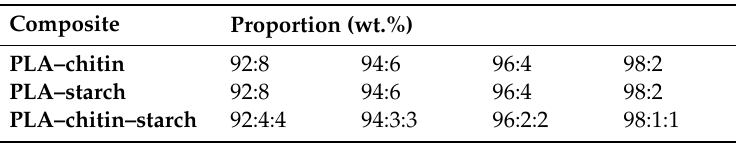
Table 2. Composition